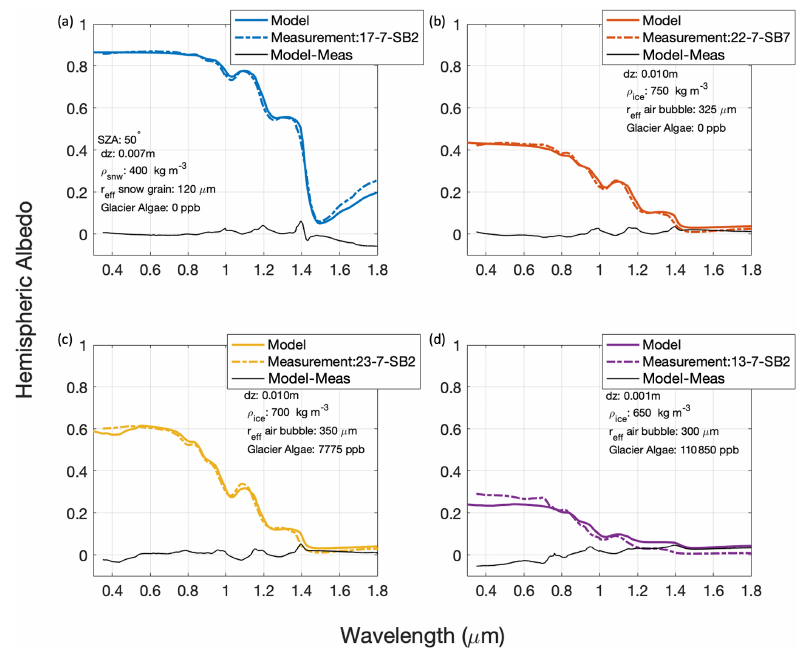
Figure 10. Spectral albedo measured by Cook et al. (2020) compared to SNICAR-ADv4 modeled spectral albedo. Model parameters are loosely based on qualitative snow and ice properties and quantitative algal cell measurements.